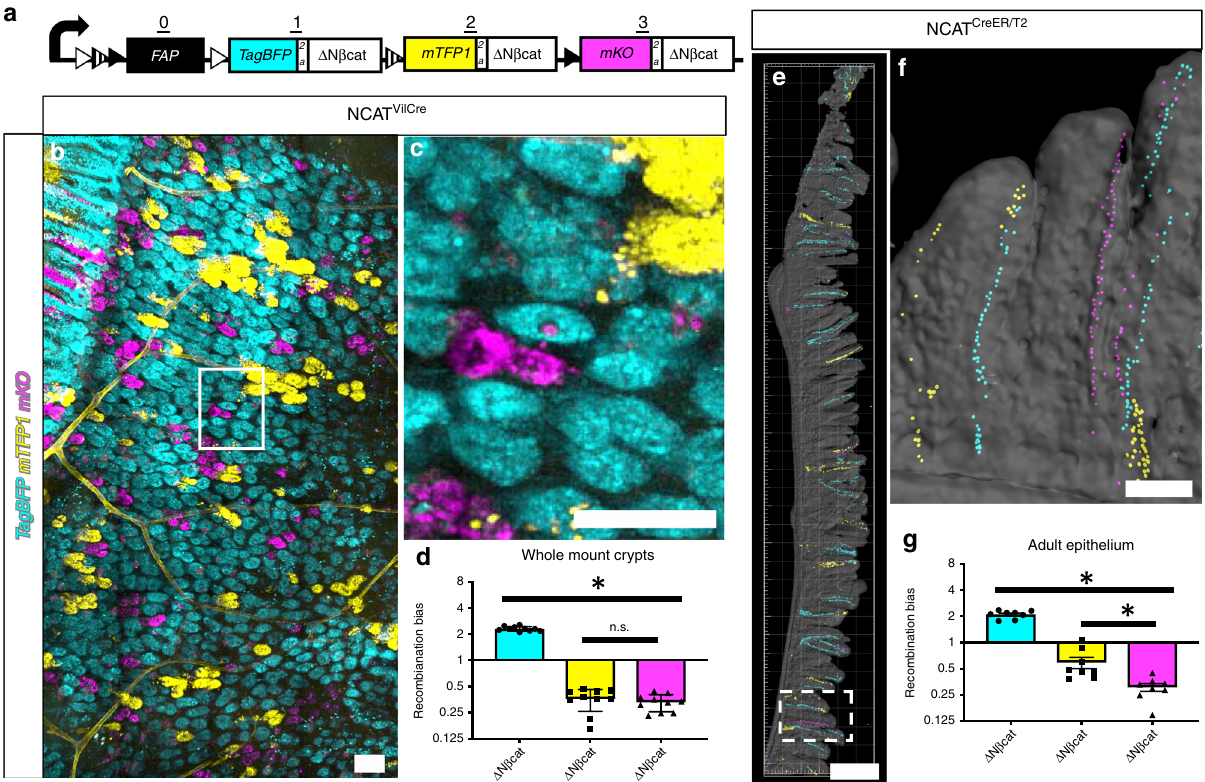
Fig. 2 Validating Crainbow functionality. a Diagram of NCAT-Crainbow mice. See also Table 1 and Supplementary Fig. 1. b NCAT VilCre small intestine ( N = 10 mice, PND9 – PND20) was prepared as a whole-mount and confocal imaged for XFP expression in the intestinal crypts. c Inset in “ b ” at higher magni fi cation. d Crypts were color segmented and counted. The experimentally observed value was normalized to the predicted stochastic outcome (0.33/ XFP). The asterisk denotes statistical signi fi cance by one-way ANOVA (TagBFP vs. mTFP1: p < 1e – 6, TagBFP vs. mKO: p < 1e – 6, mTFP1 vs. mKO: not signi fi cant). NCAT CreER/T2 mice ( N = 8, 19 – 22 weeks of age) were injected with 200 mg/kg tamoxifen. Mice were sacri fi ced 12 days post tamoxifen injection, and the small intestine was vibratome sectioned and antibody stained to recover the quenched TagBFP signal. e Sections were imaged by confocal microscopy for XFP expression (TagBFP: cyan, EYFP: mTFP1, mKO: magenta; segmented nuclear masks shown and overlaid with surface rendered tissue outline). f Rotated inset in “ e ” at higher power. g Nuclei were segmented, counted, and normalized to the predicted stochastic outcome (0.33/XFP). The asterisk denotes statistical signi fi cance by one-way ANOVA (TagBFP vs. mTFP1: p < 1e – 6, TagBFP vs. mKO: p < 1e – 6, mTFP1 vs. mKO: 8.4e – 4). (SEM included for each graph). Scale Bars = 100 µ m in b, c, f and 2 mm in e . Source data are provided as a “ Source Data fi le ”